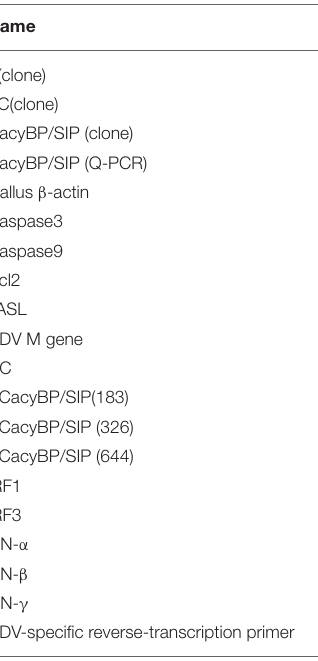
TABLE 1 | Primers and siRNA Sequence